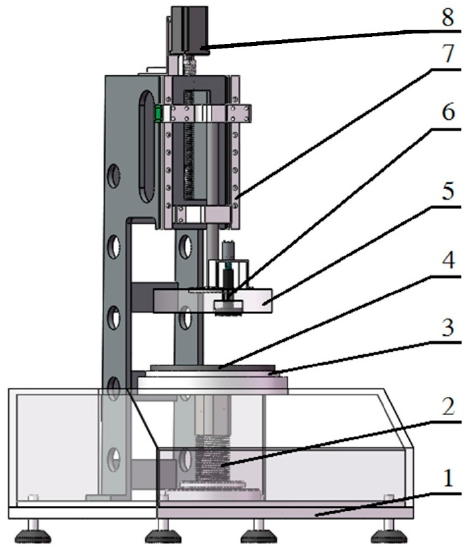
Figure 1. Mechanical structure of the multi-sensory measurement system.